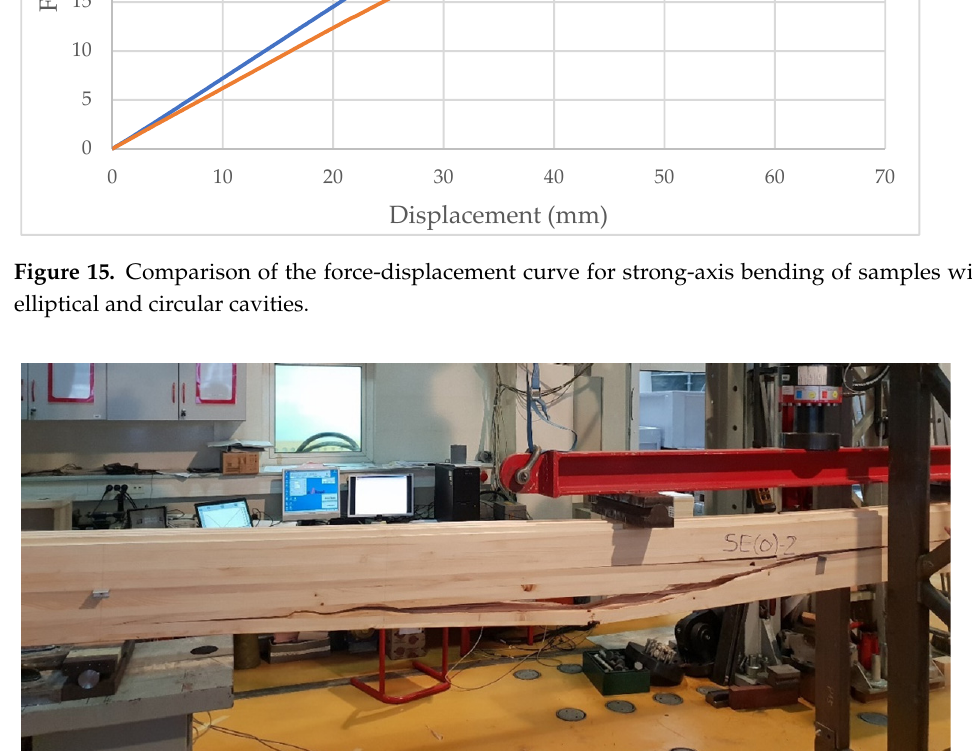
Figure 16. Failure of sample SE(0)-2 in tension.